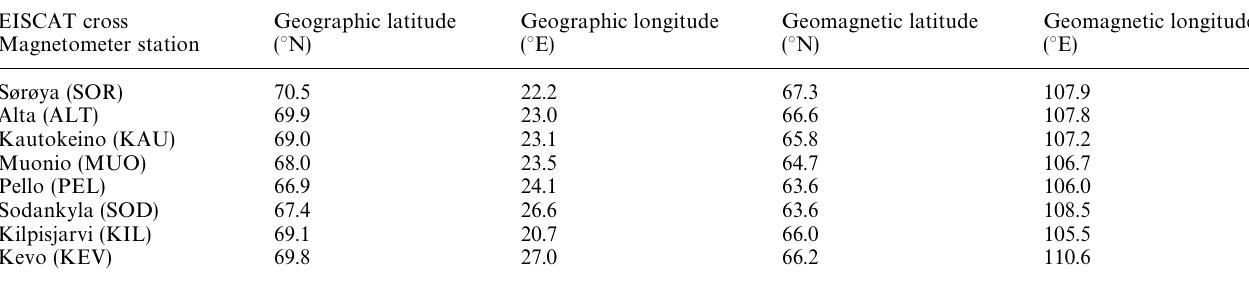
Table 2. EISCAT cross Geographic latitude Geographic longitude Geomagnetic latitude Geomagnetic longitude Magnetometer